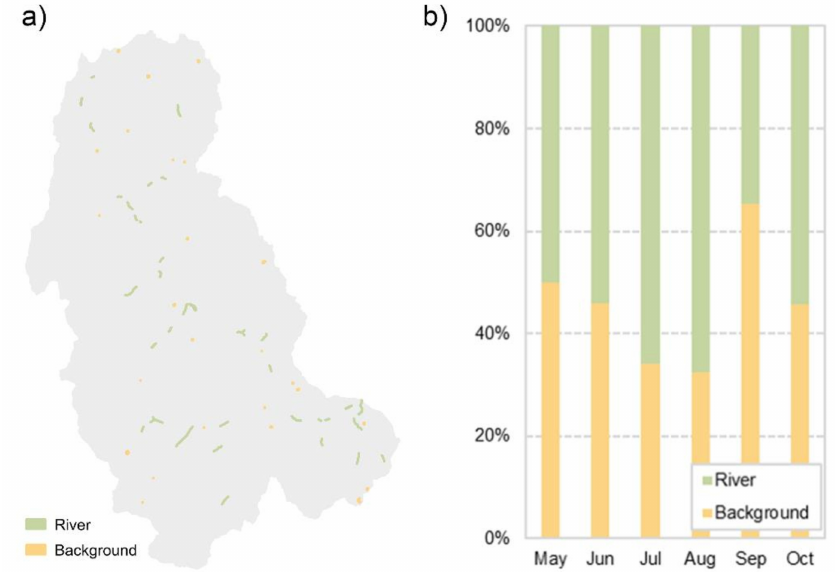
Figure 2. Validation samples. ( a ) Distribution of validation samples collected in July 2018; ( b ) Ratio of river pixels to background pixels in samples from various